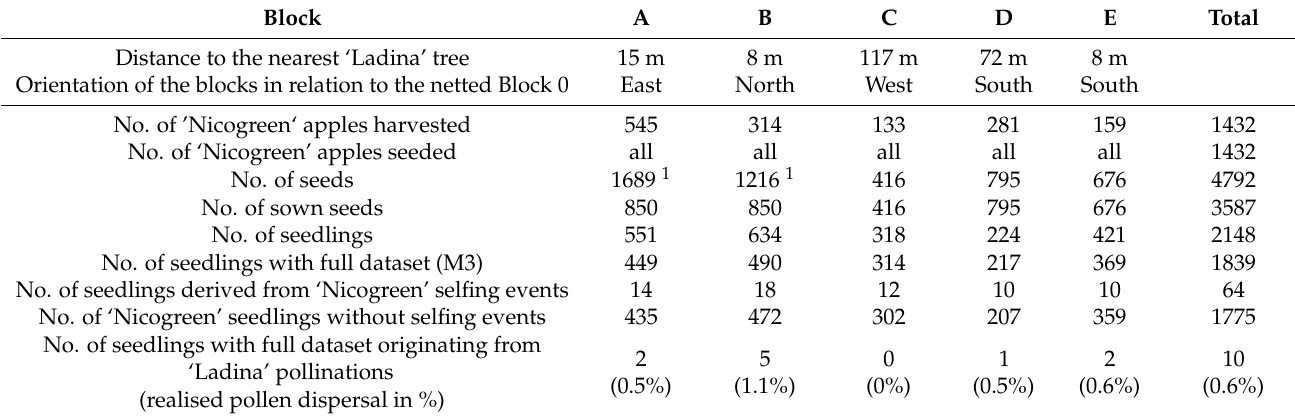
Table 3. Assessment of ‘Nicogreen’ seedlings originating from ‘Ladina’ pollination in 2019. Block A B E Total Distance to the nearest ‘Ladina’ tree 15 m 8 m Orientation of the blocks in relation to the netted Block